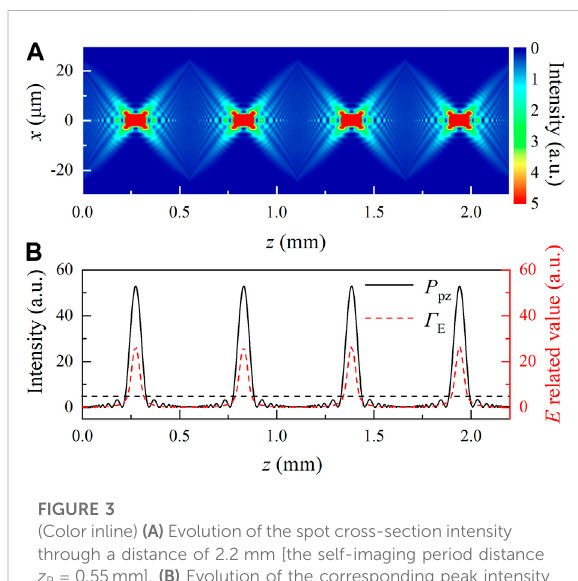
Γ E . The black dotted line